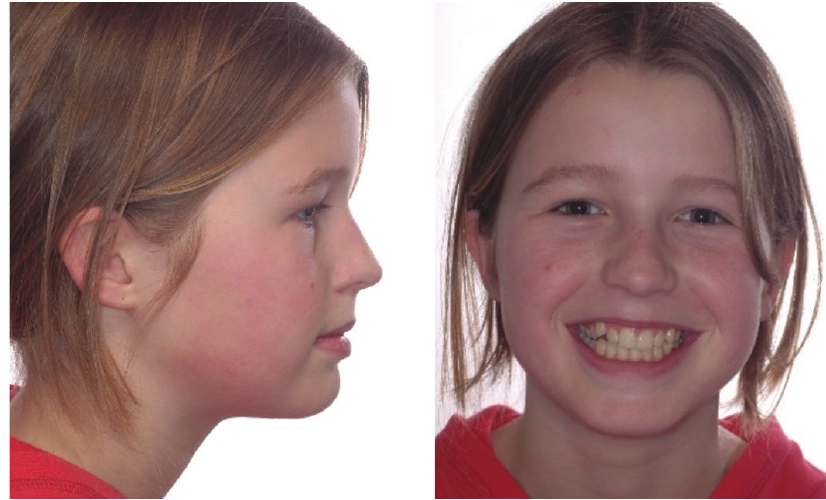
Figure 1: Pretreatment extraoral photographs.